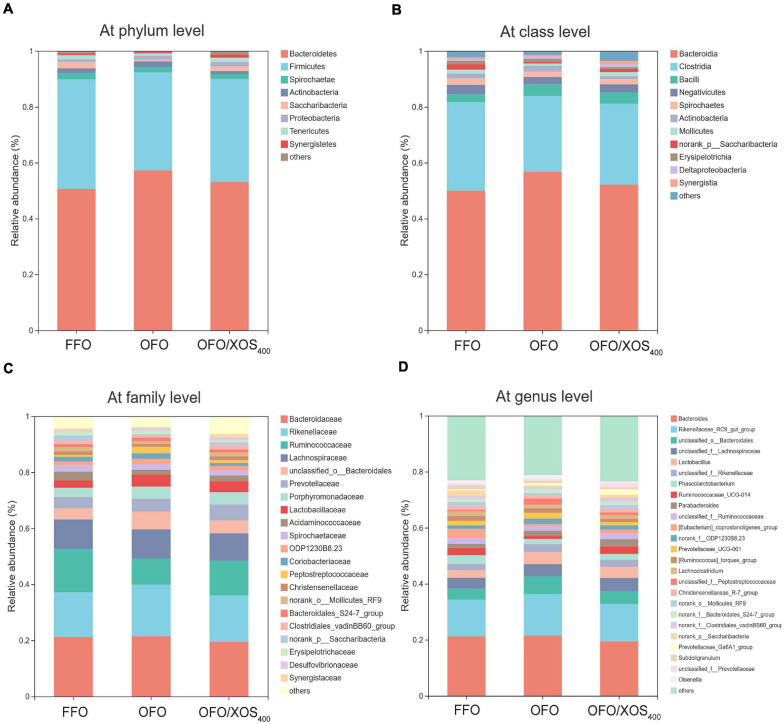
Effect of dietary xylooligosaccharide supplementation on cecal microbial composition at different taxonomic levels of laying hens fed oxidized fish oil (A) at phylum level, (B) at class level, (C) at family level, and (D) at genus level. Those abundance below 1% were classified as “others.” The relative abundance value shown in the plot represent the average of eight samples in each group. FFO, fresh fish oil diet; OFO, oxidized fish oil diet; OFO/XOS400, oxidized fish oil diet + 400 mg/kg xylooligosaccharide.